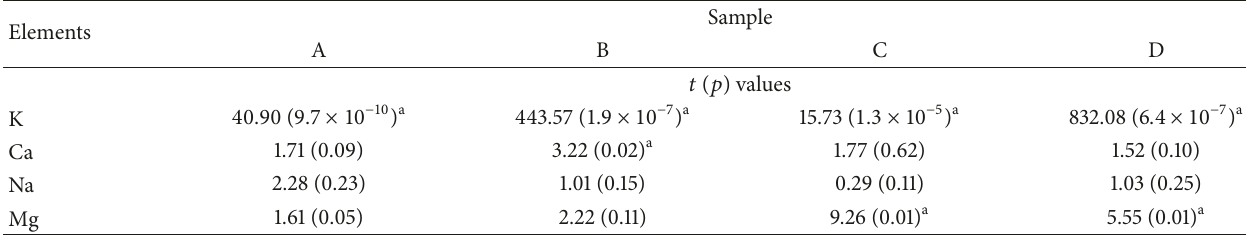
Table 4: t -test and p values between the analytical results obtained by LCGD-AES and IC.